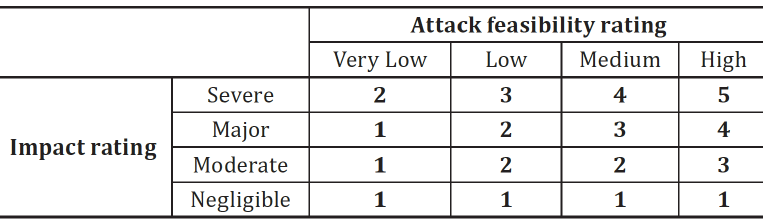
Figure 13. A risk matrix